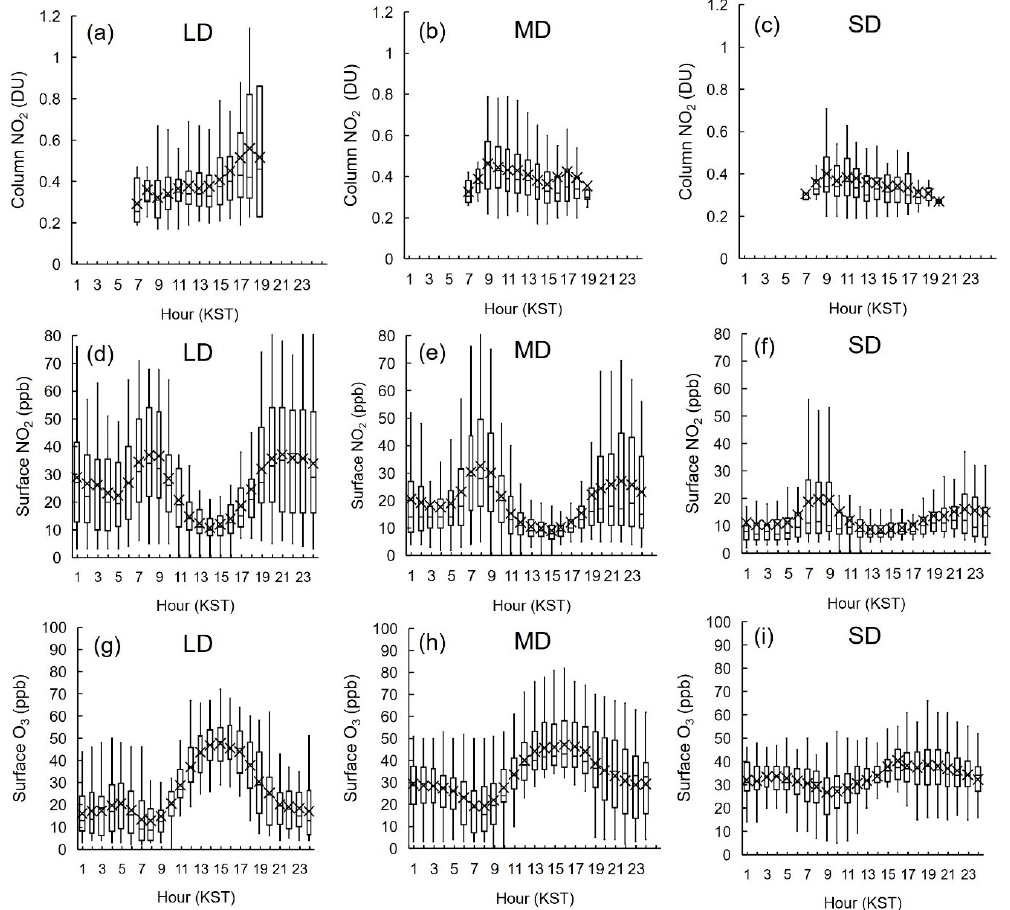
Figure 6. Box and whisker plots of diurnal variation in (a–c) PC-NO 2 , (d–f) SI-NO 2 , and (g–i) surface O 3 under synoptic wind- dominant (SD), mixed (MD), and local wind-dominant (LD) conditions in Seosan during a 1-year period (12 November 2020–30 Octo- ber